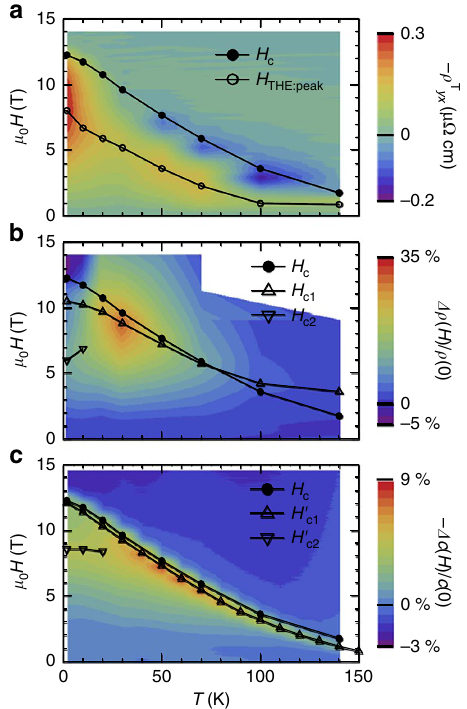
Figure 4 | Static and dynamic properties of emergent monopoles highlighted by contour mappings of unusual magneto-transport and elastic properties. Contour mappings of topological Hall resistivity ( a ), positive contribution to longitudinal MR ( b ) and elastic constant with propagation directions parallel to the magnetic field ( c ) in T – H plane. The critical fields ( H c ) are defined as inflection points in M – H curves. The magnetic field where the topological Hall resistivity shows its extremum ( H THE:peak ) and other characteristic magnetic fields ( H c1 , H c2 , H 0 are also indicated in the corresponding